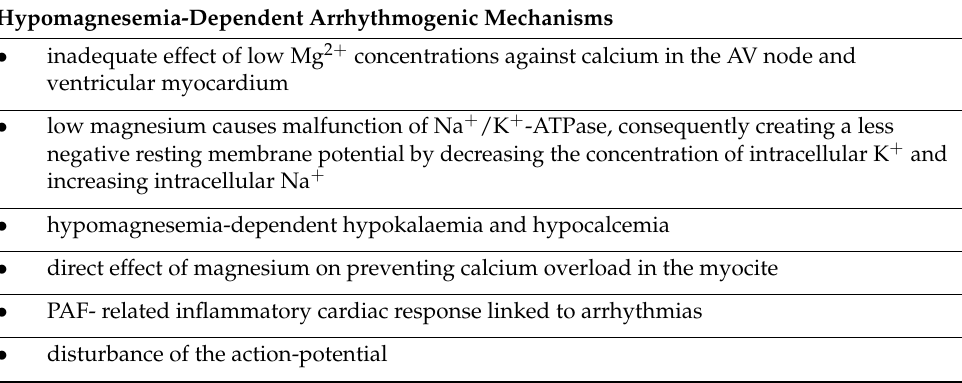
Table 2. Hypomagnesemia-induced arrhythmogenic